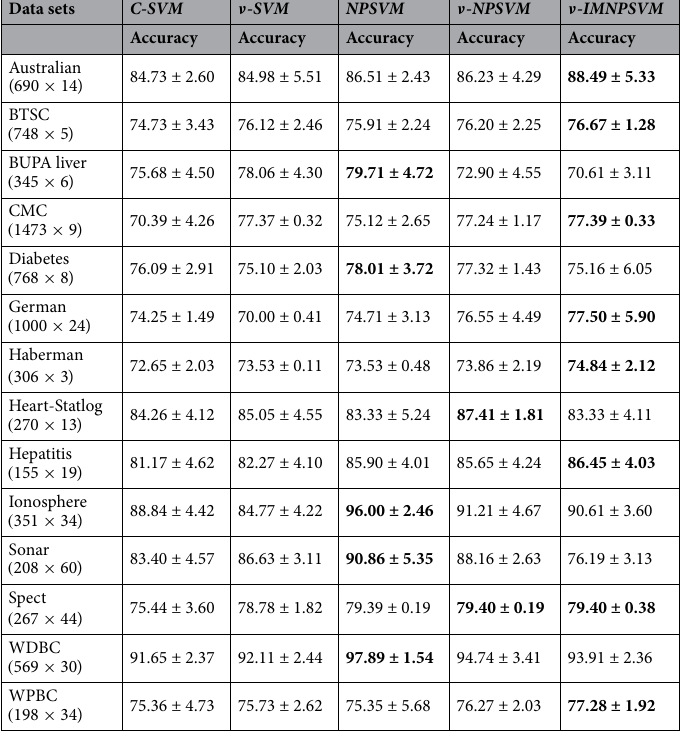
Table 2. Tenfold testing percentage accuracy of nonlinear classifiers. Significant values are in bold.